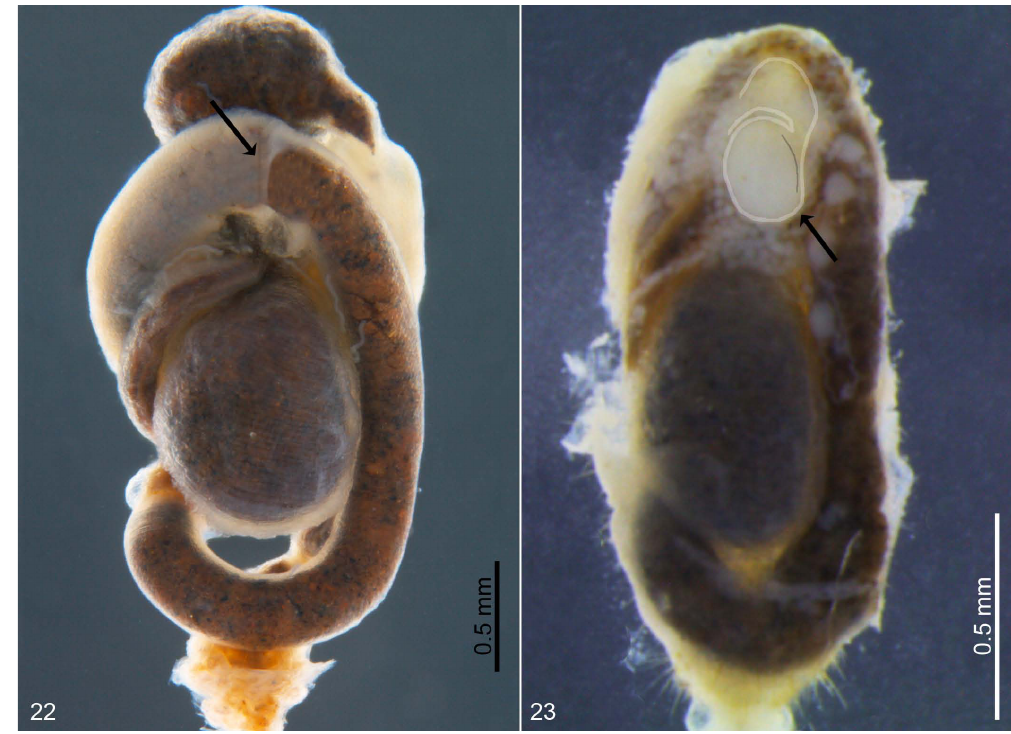
Figs 22–23. Ventral view of the gut: 22- Compositermes bani and 23- Anoplotermes pacificus . The arrows indicate the mesenteron limit (22) and the inflated portion of the mesenteric tongue (23, highlighted).